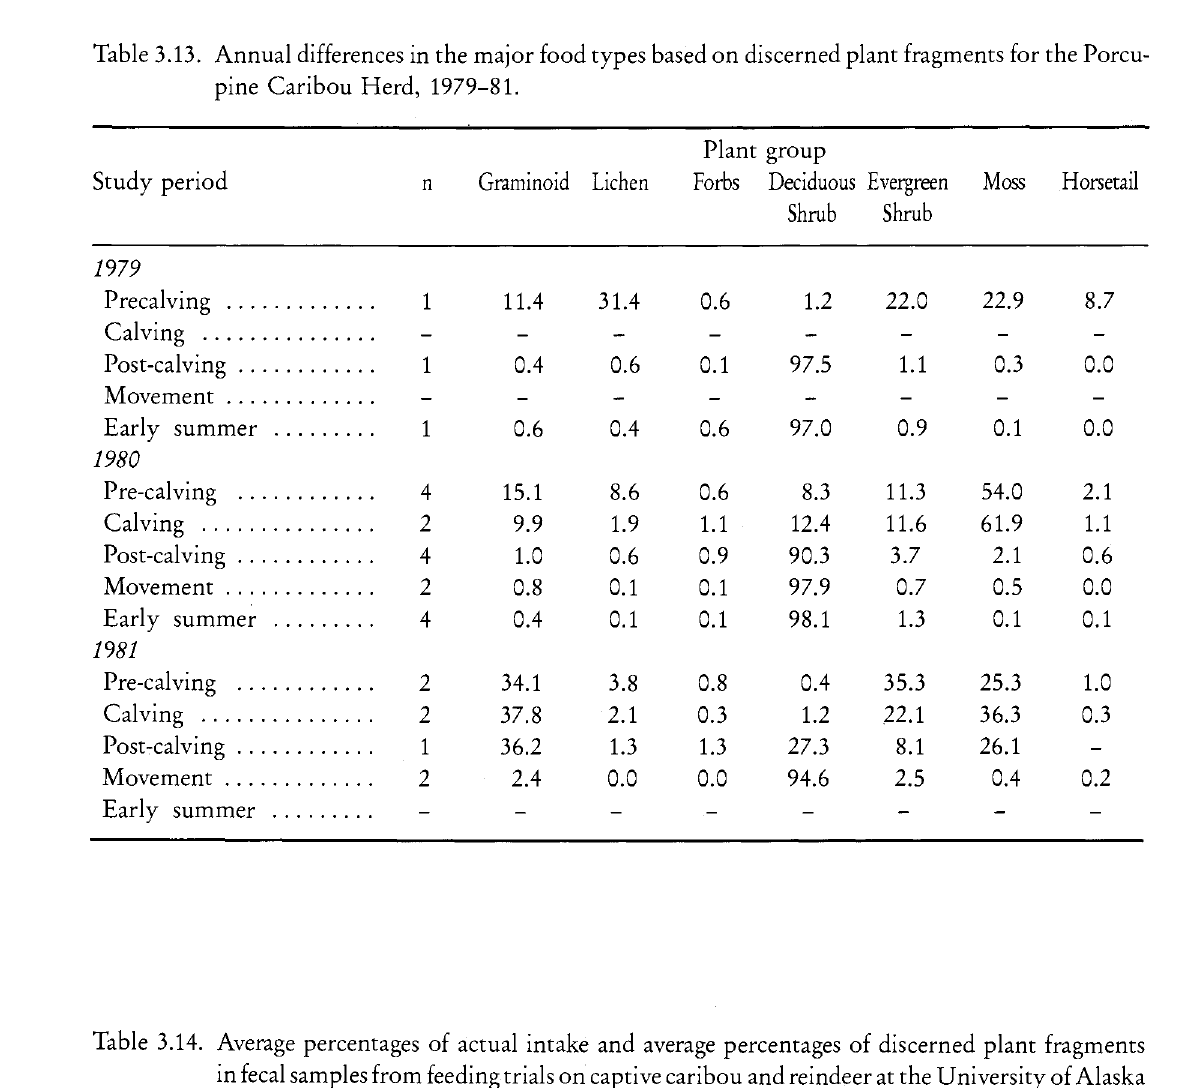
Table 3.13. Annual differences in the major food types based on discerned plant fragments for the Porcu pine Caribou Herd, 1979-81.